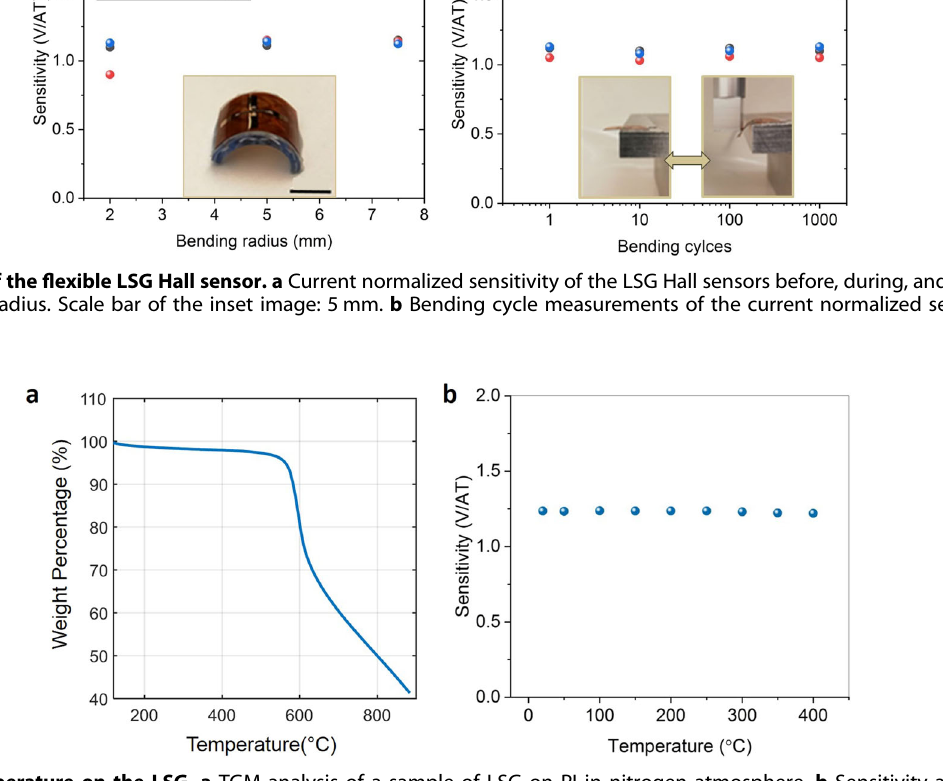
Fig. 4 Effects of temperature on the LSG. a TGM analysis of a sample of LSG on PI in nitrogen atmosphere. b Sensitivity as a function of